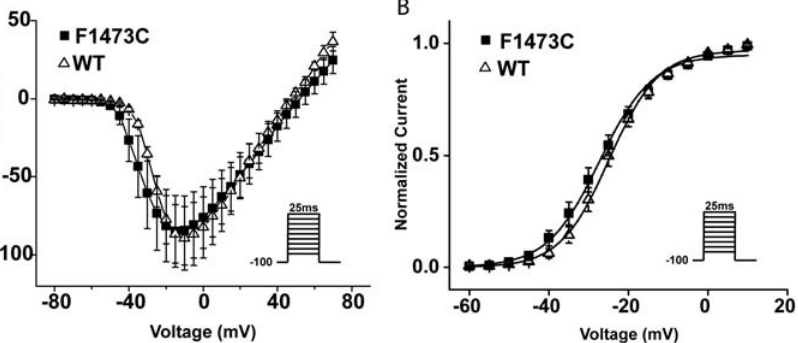
Figure 3. The F1473C mutation does not affect the voltage dependence of Na + channel activation. A. Mean current voltage relationships recorded in low external sodium solution (Methods S1) in response to 25 ms voltage pulses from 2 80 mV to + 75 mV (5 mV increments) for WT (n=13, open triangles) and F1473C (n=7, closed squares). B. Mean activation curves obtained from data in A, for WT (open) and F1473C channels (filled) show no affect of the F1473C mutation on the voltage dependence of activation (see text for